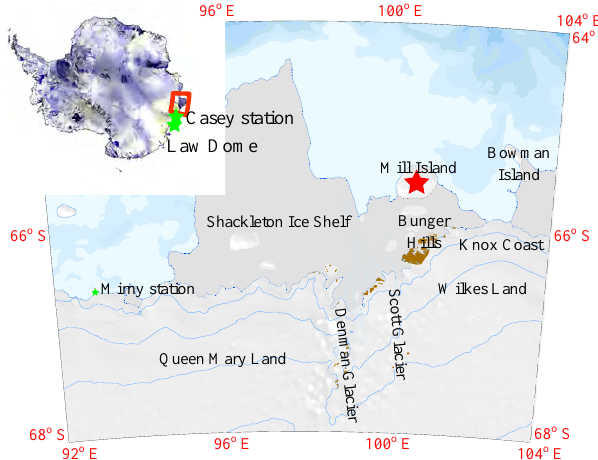
Figure 1. Location of Mill Island, East Antarctica. Mill Island is located adjacent to the Shackleton Ice Shelf, north of Bunger Hills. The red star shows the location of the 120m Mill Island ice core (MI0910). This map is modified from map number 13976 produced by the Australian Antarctic Data Centre, courtesy of the Australian Antarctic Division (Commonwealth of Australia © , 2012).